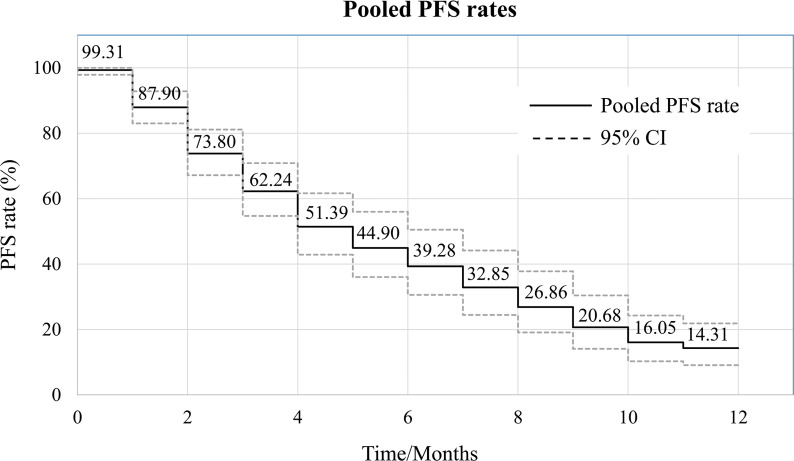
Pooled survival curve regarding progression-free survival (PFS) (each PFR was synthesized using meta-analysis of single rate).